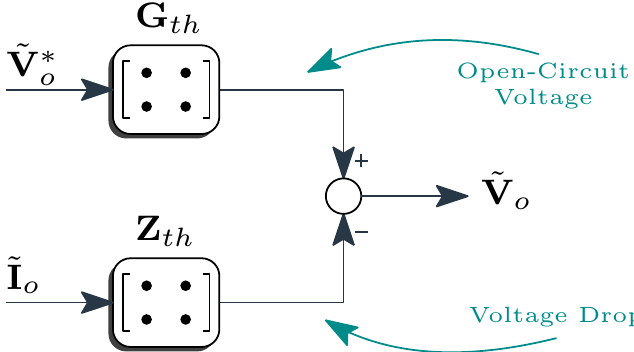
Figure 4. Block diagram representing the MMC equivalent model (equivalent